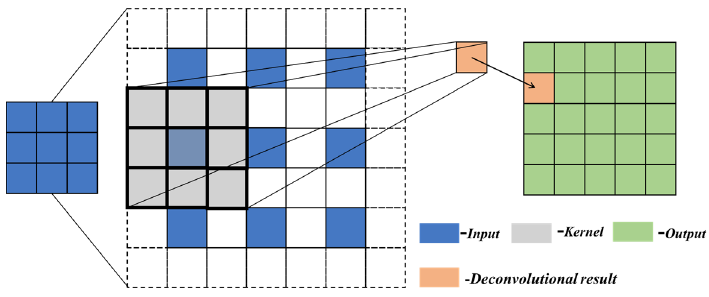
Figure 2. A simple sketch of the deconvolutional layer.